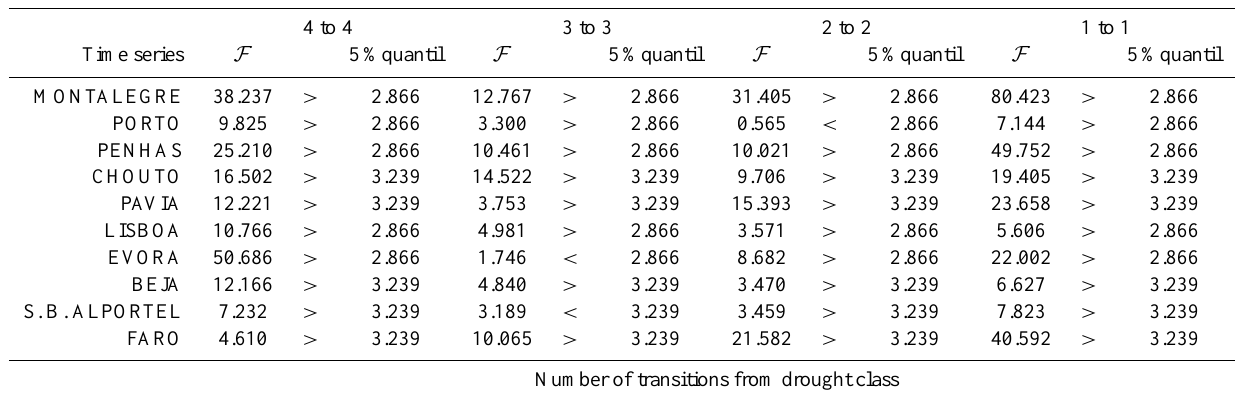
Table 4. Results of the F test ( > significant differences between sub-periods; < no significant differences between sub-periods). Number of transitions from drought class